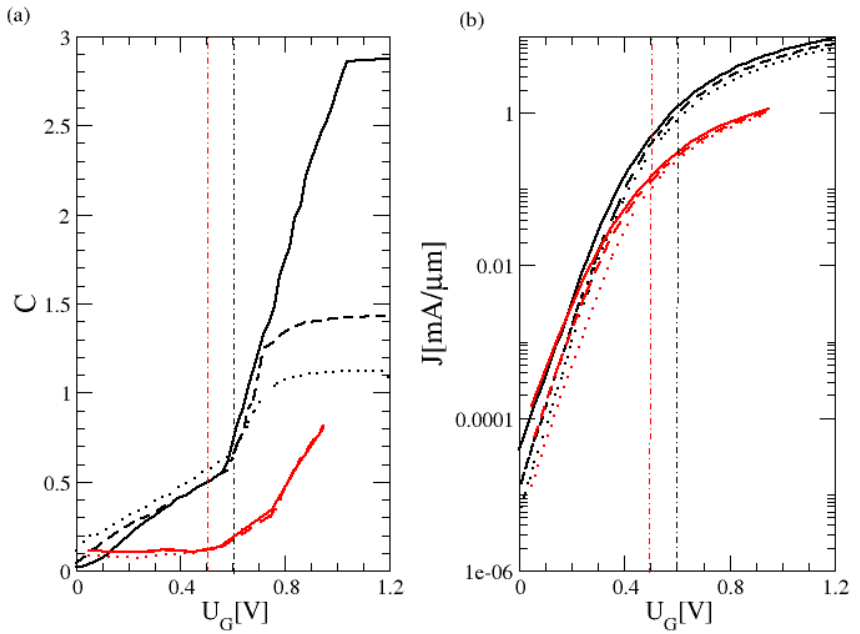
Figure 6. ( a ) Overlap parameter and ( b ) experimental transfer characteristic at U D = 0.95 V at room temperature: in black for the C-transistors (C1 solid, C2 dashed, C3 dotted) and in red for the A-transistors (A1 solid, A2 dashed, A3 dotted). The threshold voltage U th vertical line for the